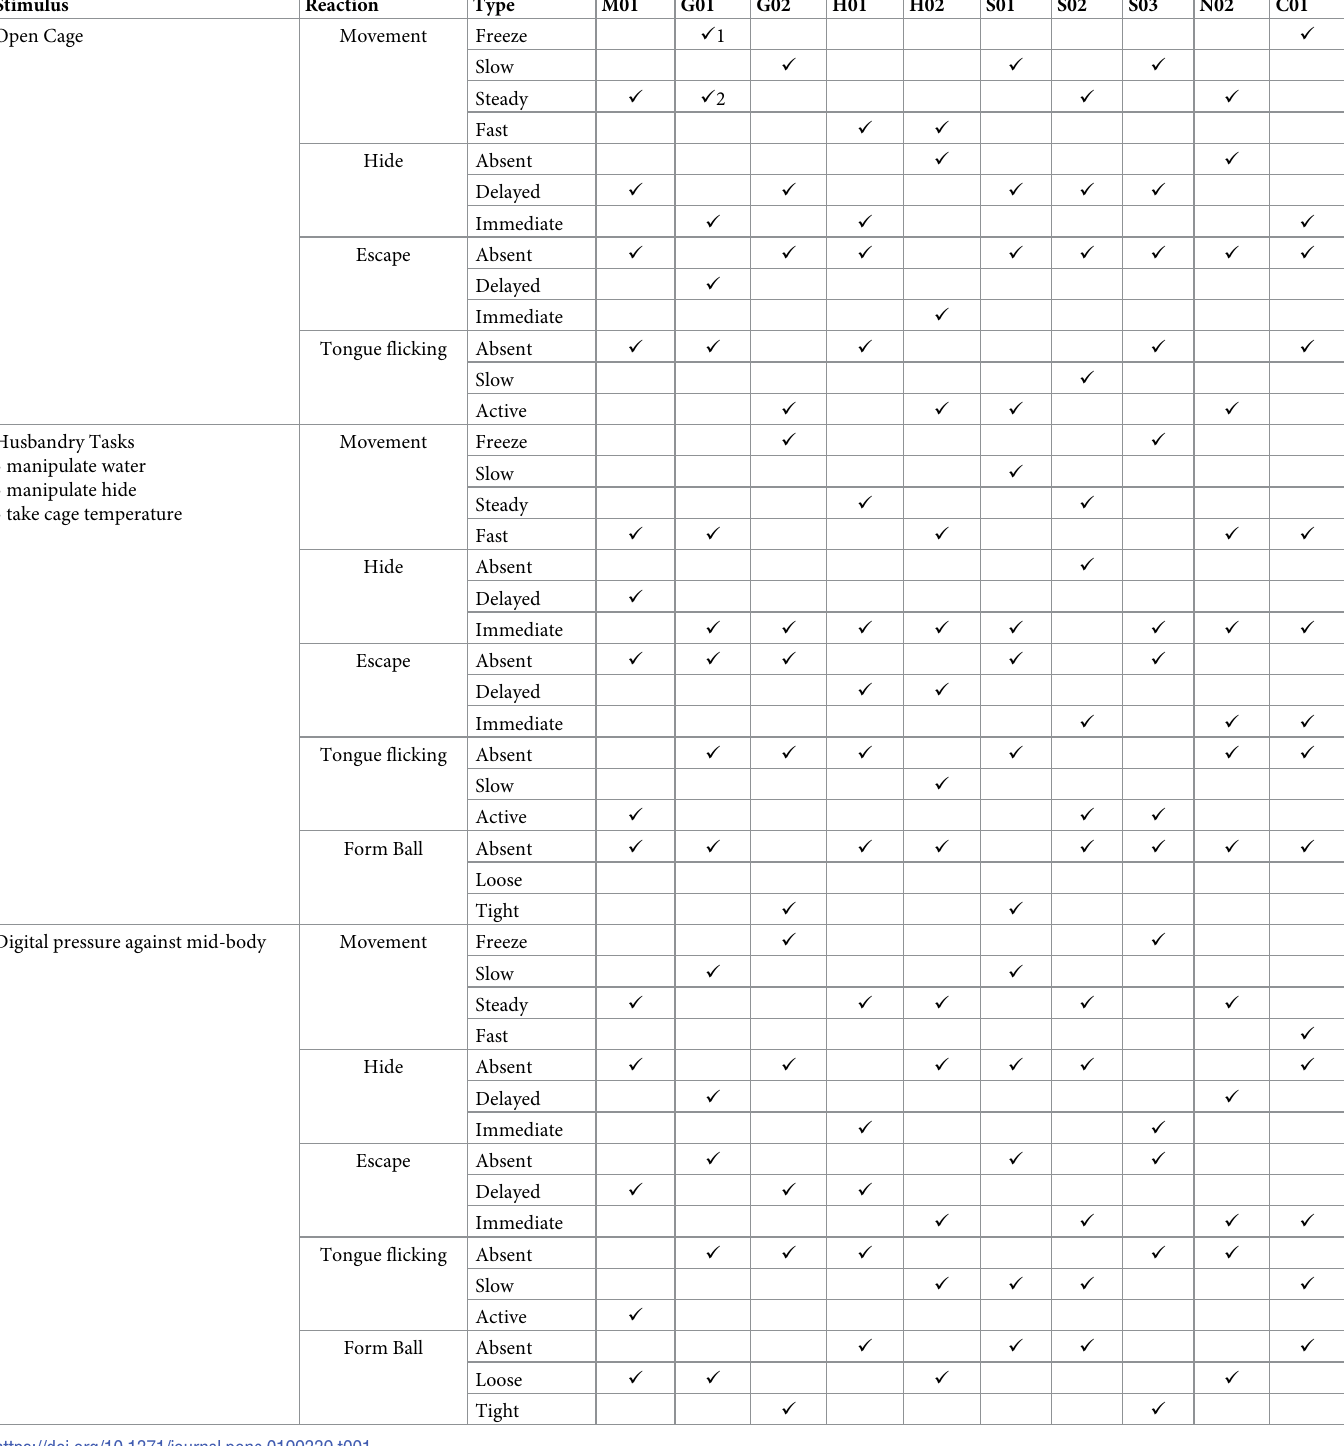
Table 1. Ball python baseline ethogram.